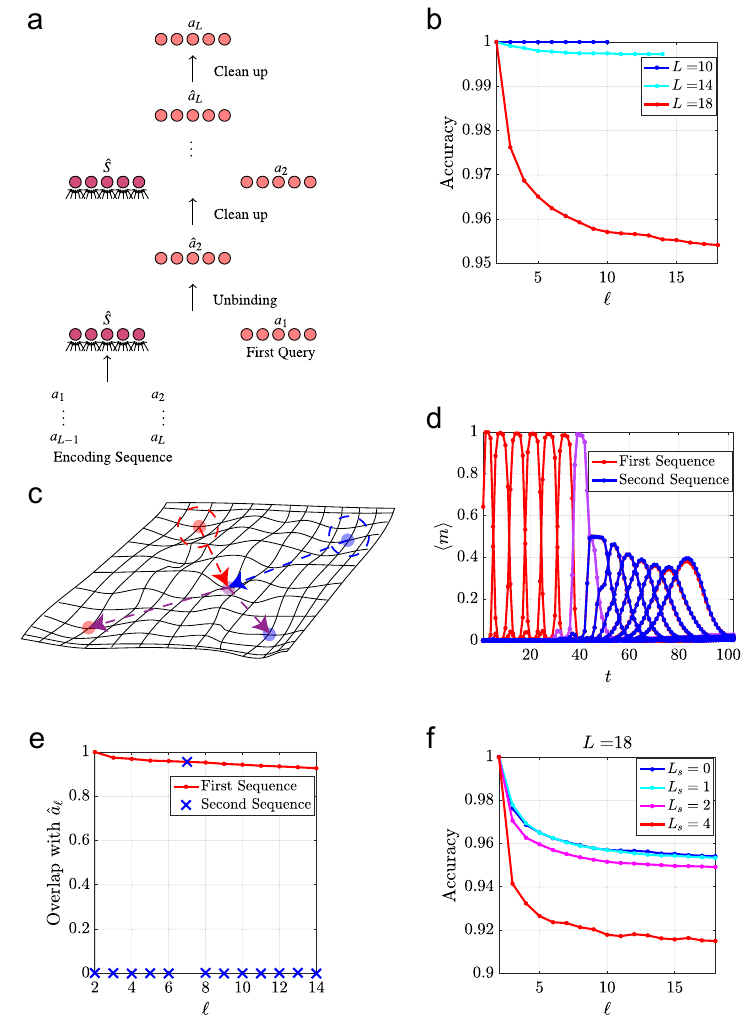
Figure 6. ( a ) A schematic of the decoding scheme for sequences. ( b ) Decoding accuracy as a function of sequence position ℓ along sequences of length L retrieved from memory shown for several values of L . 2500 , α 0.05 , and the average is computed over 100 trials. ( c ) A schematic of the energy landscape for N = = two temporal sequences containing a single common element which are encoded as sequences of attractors using the scheme in 34 (discussed in Section 4 of the Supplementary Material). ( d ) The average overlap of the m network state with each attractor in the sequence is shown as a function of retrieval time for a network (cid:31) (cid:30) 1000 storing two sequences containing a single element in common. The parameters τ of size N = (cid:31) 2.5 are used and the average is computed over 1000 trials. ( e ) The average overlap of the estimator = a 2 a 2 (normalized by ) with the correct Dictionary item at each position in the sequence for a network of �ˆ · � 1000 storing two sequences containing a single element in common. The average is computed over size N = 10, 000 trials. ( f ) Decoding accuracy as a function of sequence position ℓ for P neighboring sequence contain L s common elements with the previous one. N is computed over 100